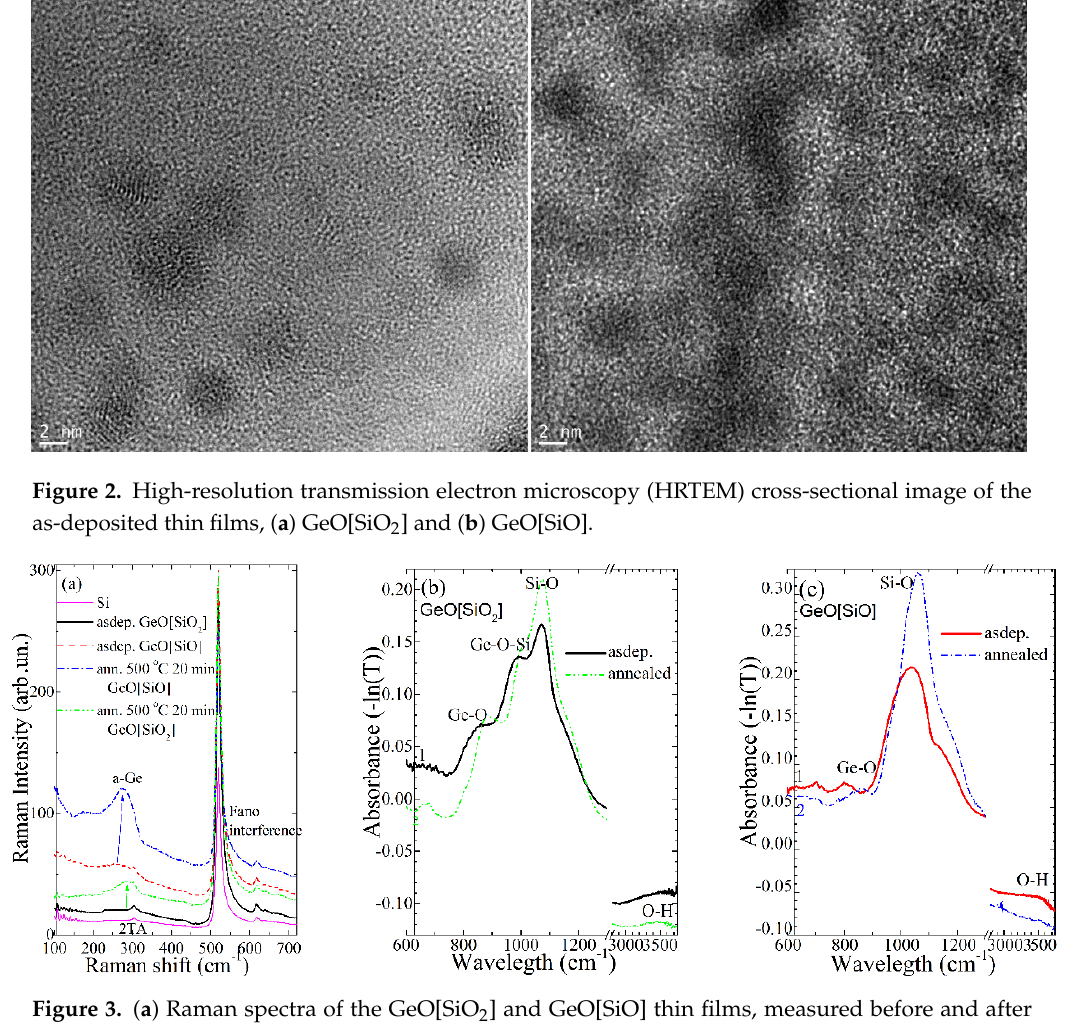
Figure 2. High-resolution transmission electron microscopy (HRTEM) cross-sectional image of the as- deposited thin films, ( a ) GeO[SiO 2 ] and ( b ) GeO[SiO].